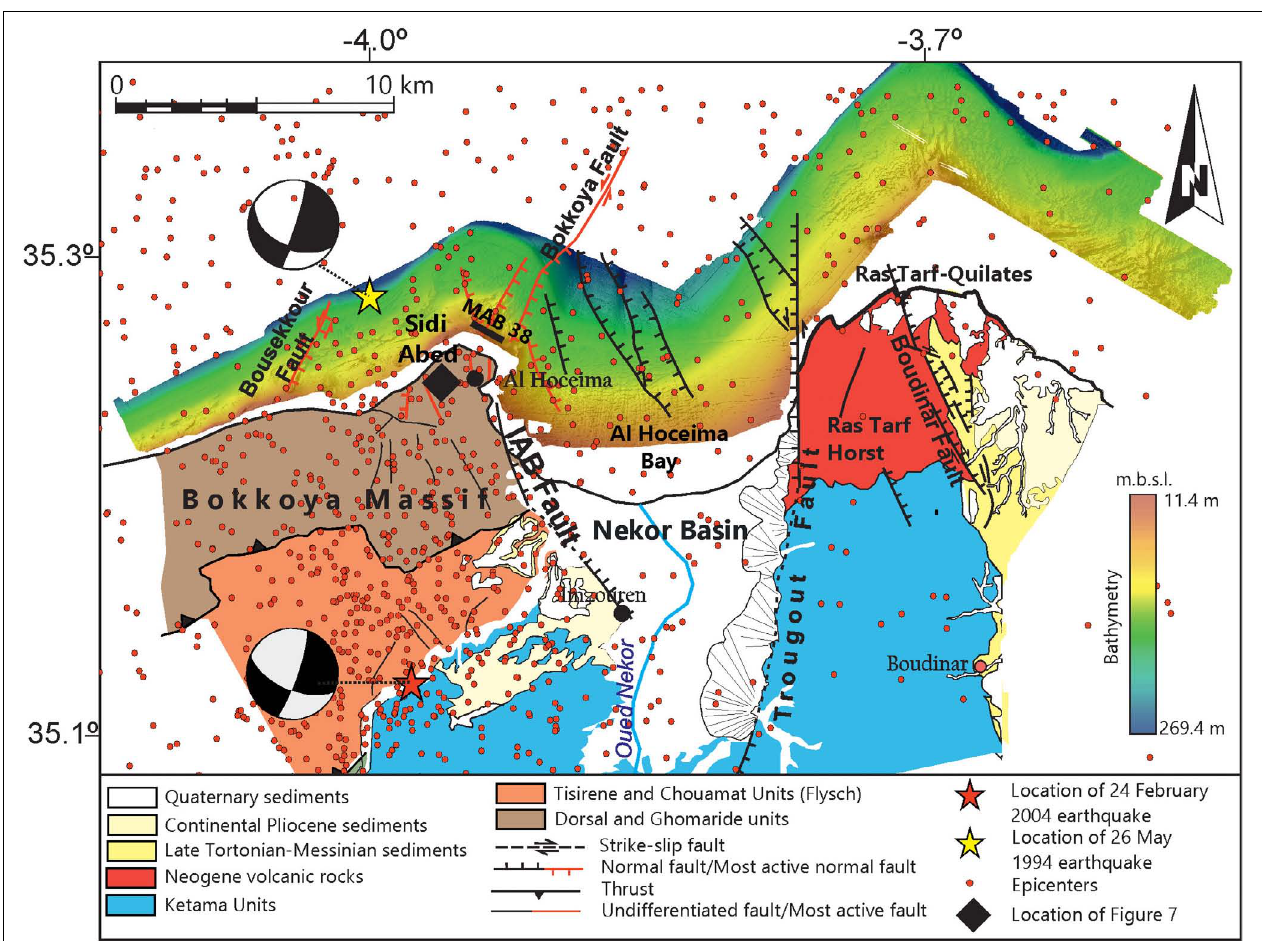
FIGURE 2 | Geological map of Nekor Basin and swath-bathymetry of the Al Hoceima margin from Marlboro-2 Survey (modified from d’Acremont et al., 2014; Galindo-Zaldívar et al., 2015). Seismicity from IGN catalog 2000–2020; earthquakes with Mw > 1.5, and the position of the main shocks of the seismic series of 2004 and 1994 from Calvert et al. (1997) and Van der Woerd et al. (2014). The focal mechanisms of both earthquakes are from Van der Woerd et al. (2014). The location of the outcrop of Sidi Abed presented in Figure 7 and MAB 38 profile is also